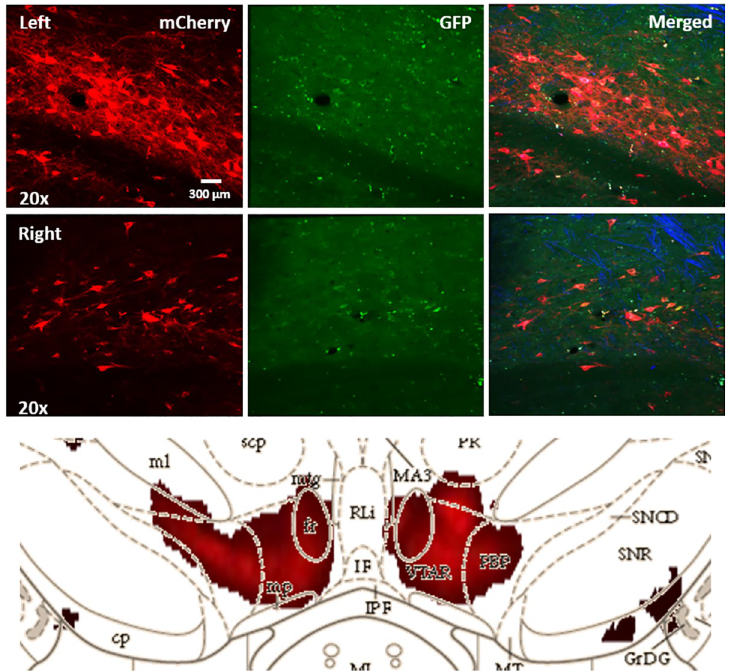
Fig 3. Histological identification of DREADDs expression. Virus-infused cortical tissues were sectioned into 50 μ m thick coronal slices to determine which neuronal VTA subpopulations were infected by the AAV-hSyn-DIO-hM3D (Gq)-mCherry virus and stimulated by CNO. hM3D(Gq) receptors (as indicated by mCherry expression) were predominantly expressed in neurons of the pVTA. Blue DAPI (4’,6-diamidino-2-phenylindole) staining suggest that hM3D(Gq)-mCherry expression was limited to a subset of pVTA neurons that communicate with the AcbSh.